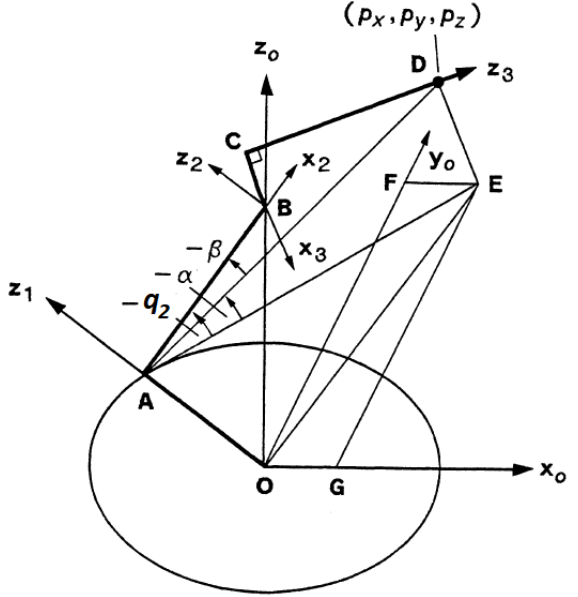
Figure 6. Geometric solution for joint 2 ( q 2 )